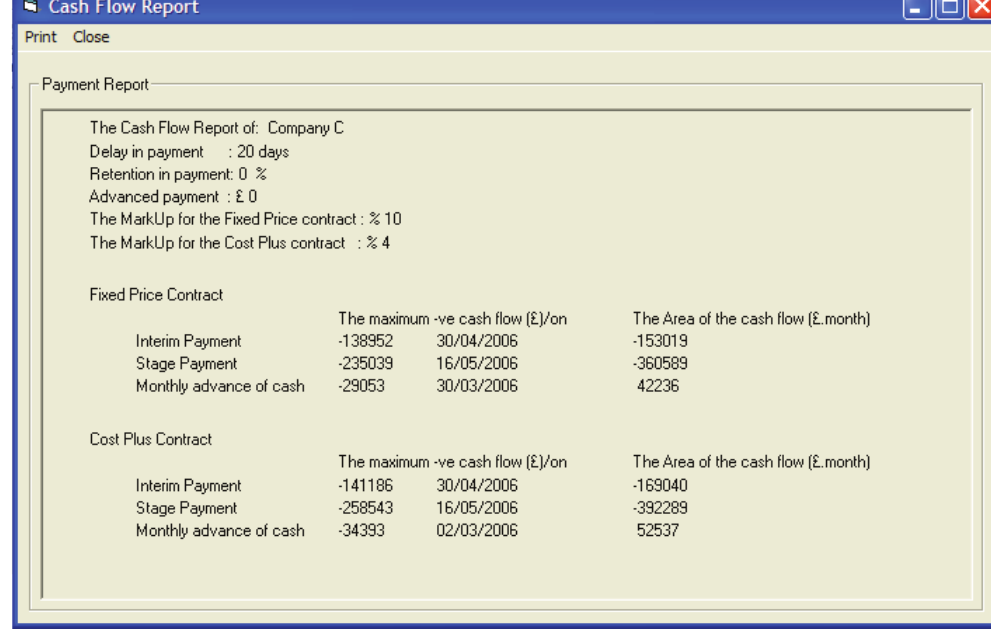
Figure 5. System output (reports on different payment methods for company C)